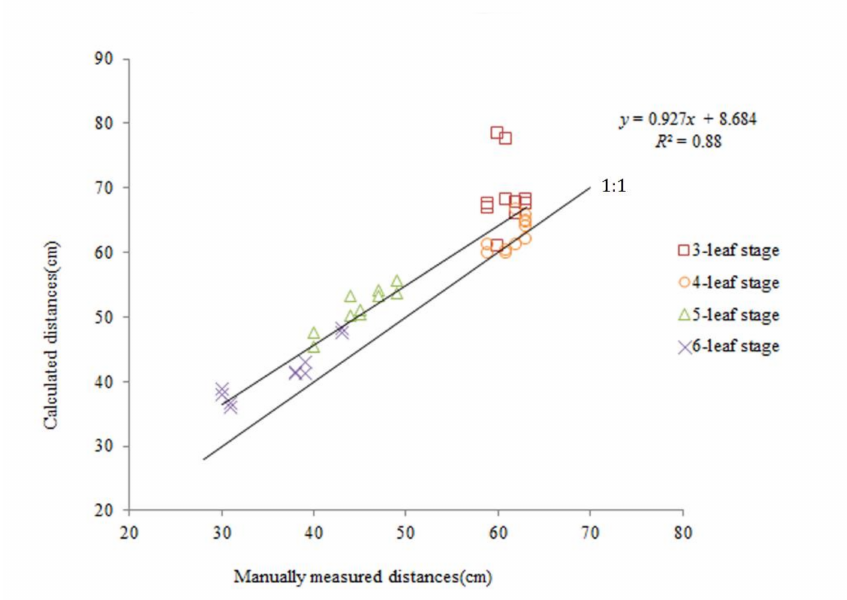
Figure 5. Calculated distances regressed onto manually measured distances from the sensor to the canopy for corn plants including all growth